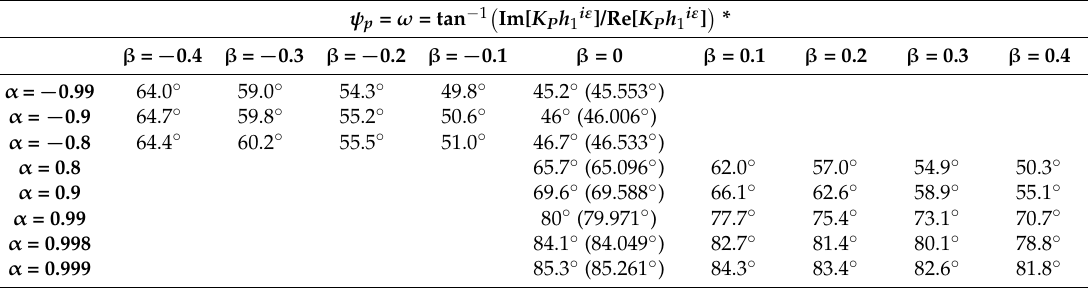
Table 3. Mode-mixity phase angle associated with the axial force, Figure 1a, with P (cid:54) = 0, M = V =